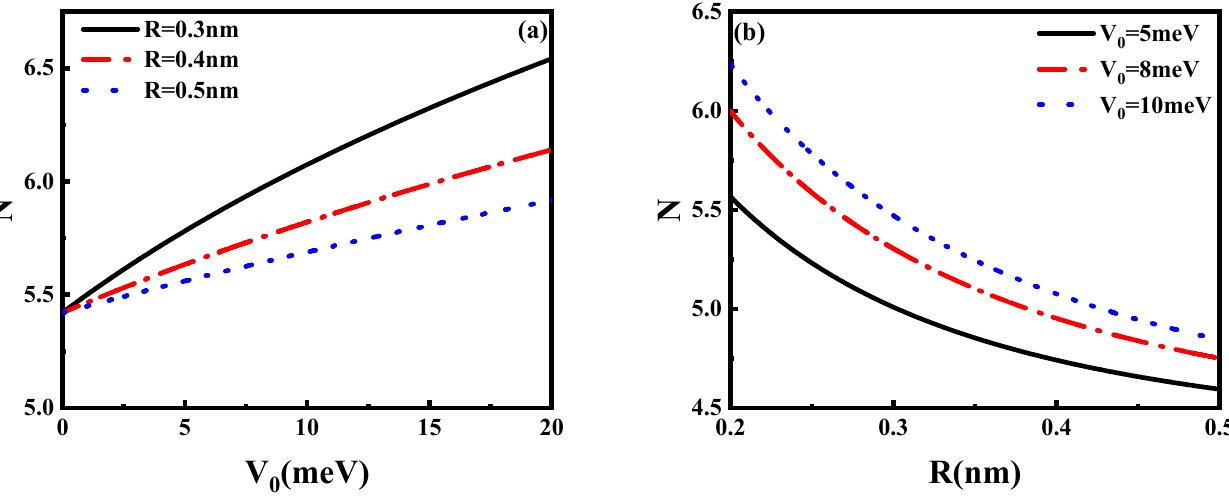
Figure 3. Vibrational frequency λ versus ( a ) AGCP barrier height V 0 and ( b ) AGCP range R. (cid:2868)